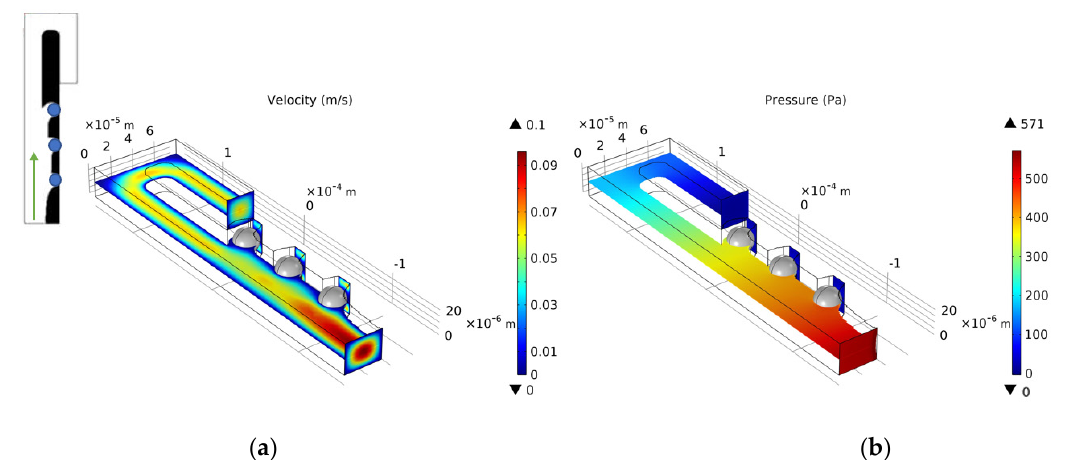
Figure 14. ( a ) The velocity field distribution and ( b ) pressure field distribution of 3D model with two captured cells.